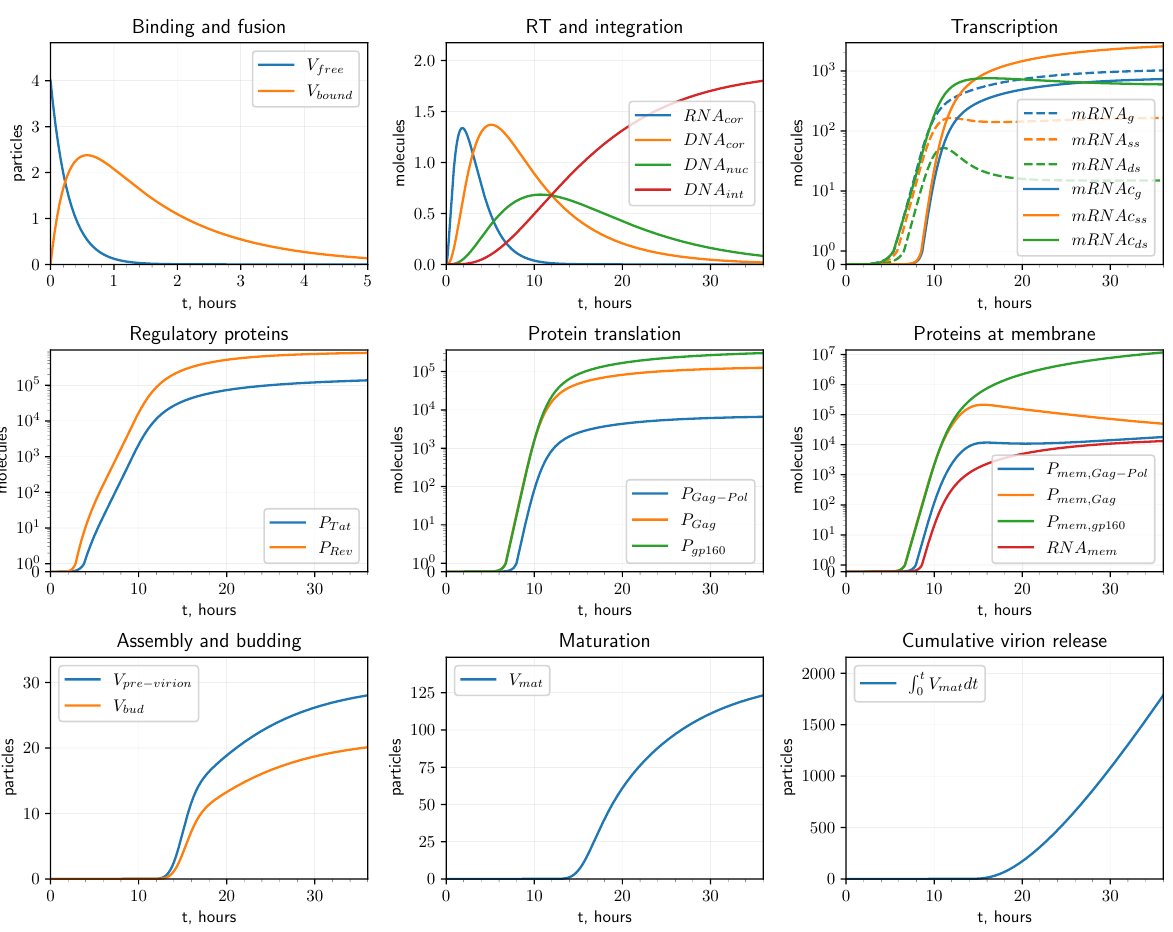
Figure 2. Numerical solution of the deterministic model of HIV-1